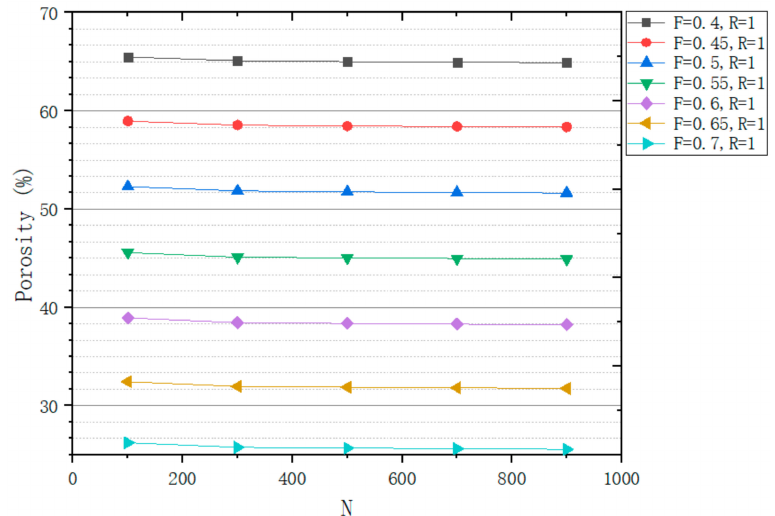
Figure 15. Relationship between N and porosity.